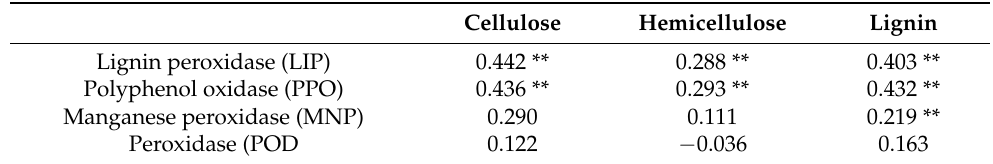
Table 3. The correlation coefficient between enzyme activity and degradation rate of cellulose, hemicellulose and lignin. Cellulose Hemicellulose Lignin Lignin peroxidase (LIP) 0.442 ** 0.288 ** 0.403 ** Polyphenol oxidase (PPO) 0.436 ** 0.293 ** 0.432 ** Manganese peroxidase (MNP) 0.290 0.111 0.219 ** Peroxidase (POD 0.122 − 0.036 0.163